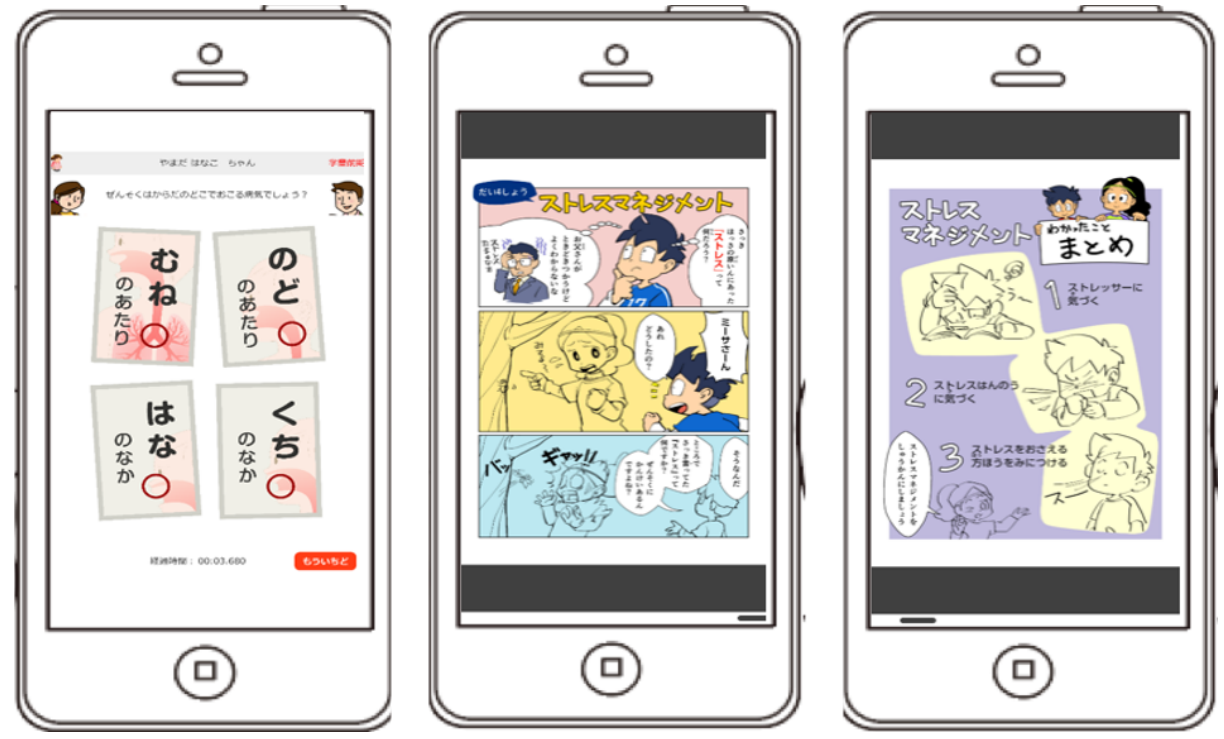
Figure 3. Examples of the features of asthma knowledge for 7- to 12-year-old children: asthma quiz (left) and manga about stress management of asthma (middle and